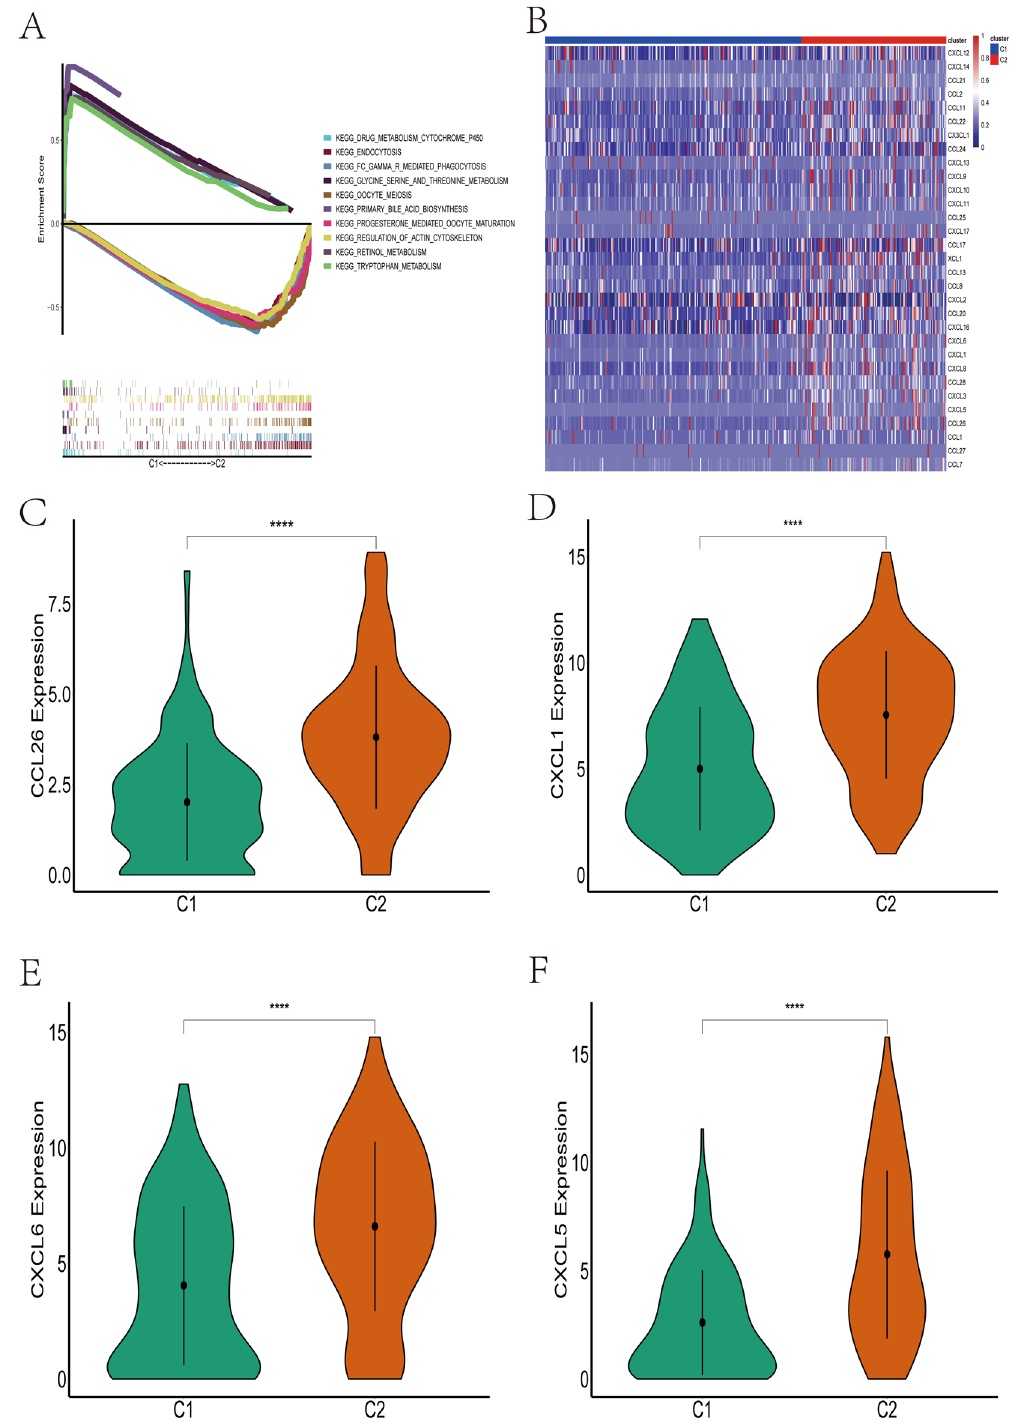
Figure 2. Differential expression of chemokine-related genes among different clusters. ( A ) GSEA enrichment analysis shows that different clusters are involved in different signaling pathways. ( B ) The heatmap demonstrates significant differences in the expression levels of chemokine-related genes between the different clusters. ( C – F ) The expression levels of chemokine-related genes were significantly higher in patients in the C2 group than in C1, including CCL26 ( C ), CXCL1 ( D ), CXCL6 ( E ) and CXCL5 ( F